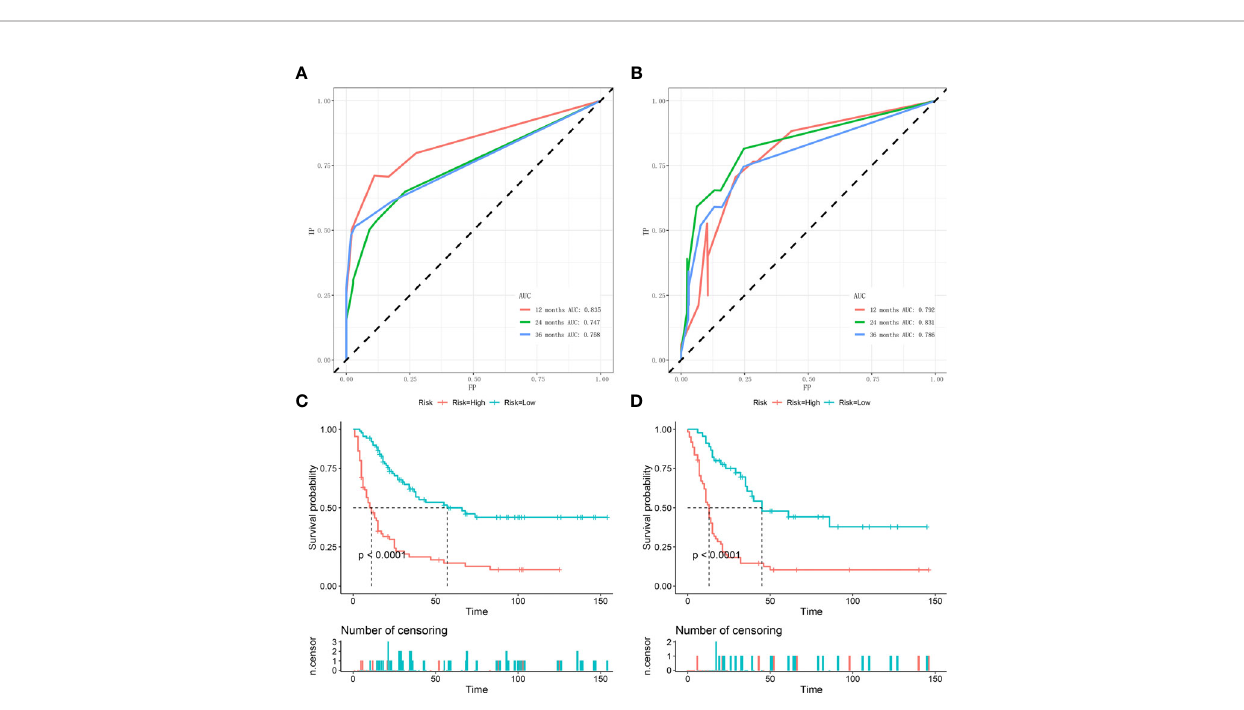
FIGURE 6 | Time-dependent ROC curve analysis of the nomogram for the 12, 24, and 36 months in the training set (A) and the validation set (B) . The Kaplan – Meier survival curves of the patients in the training set (C) and in the validation set (D) .